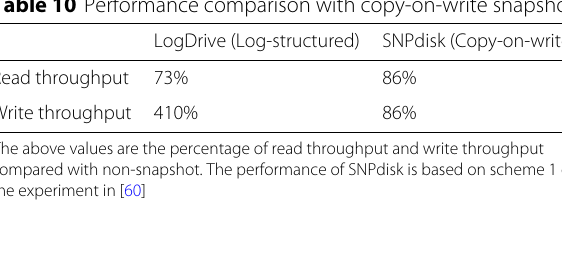
Algorithm 3 . Algorithm 3 consists of two parts.